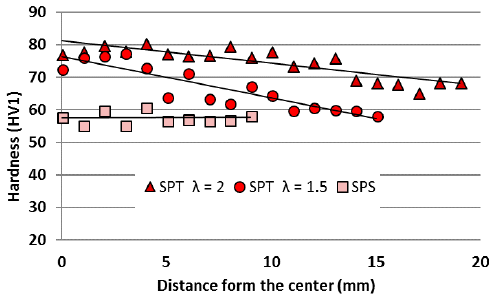
Figure 8. Hardness profile along part of the cross-section of AA6061/MoS 2 10 vol % composite.